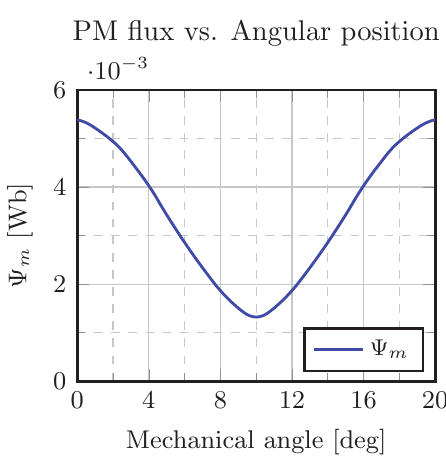
Figure 5. PM flux linkage as function of position of the HM3D